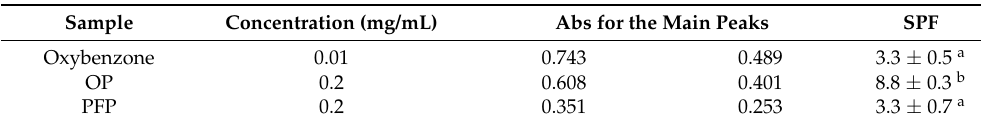
Table 3. Sun protection factor (SPF) for oxybenzone (synthetic UV filter), onion peel extract and passion fruit peel